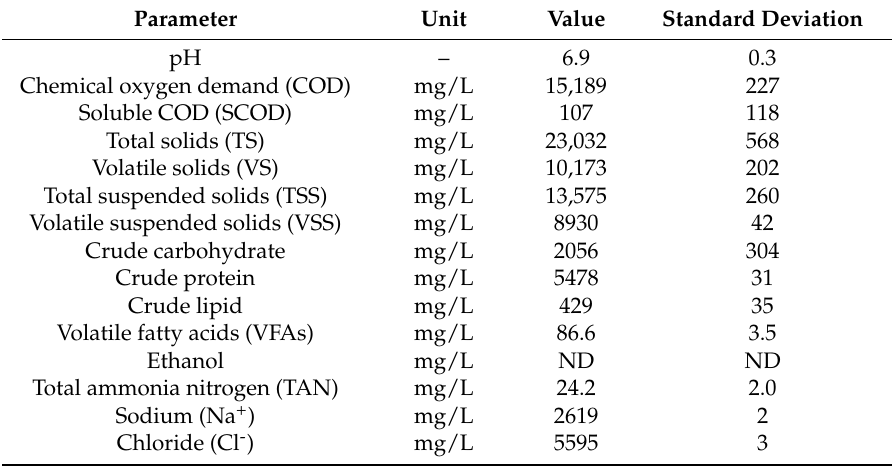
Table 1. Characteristics of the WAS used in this